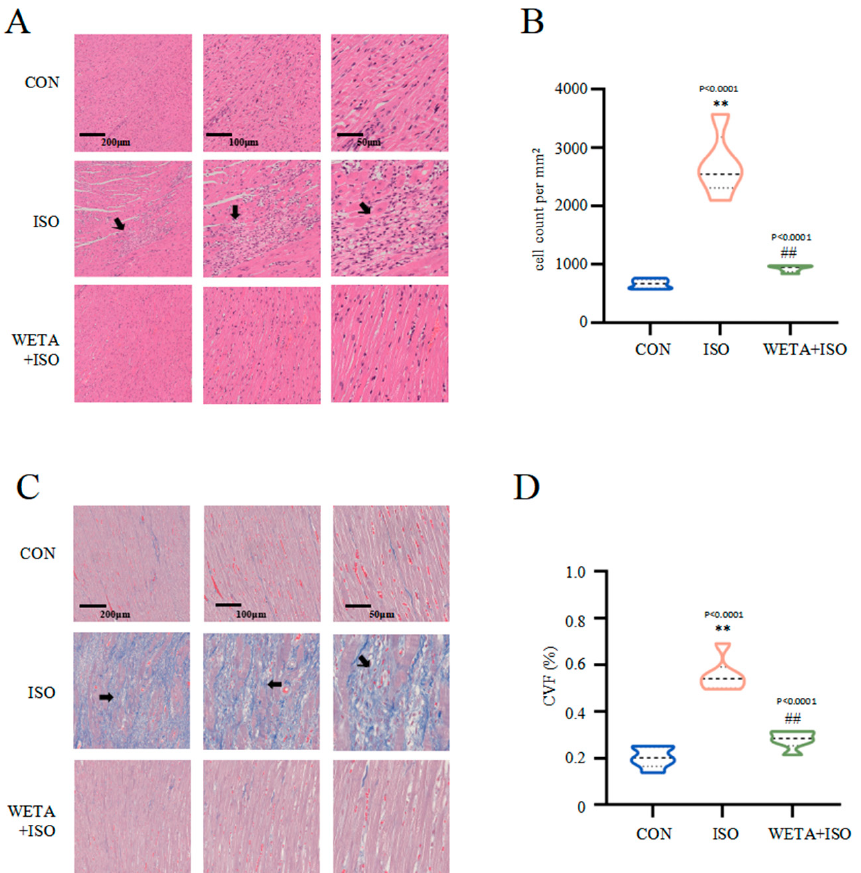
Figure 5. WETA attenuates histopathological changes. ( A ) H&E staining images of LV (From left to right, scale bar = 200 µ m, 100 µ m, 50 µ m), ( B ) Positive cells in the H&E stained slices were normalized and counted as cells/mm 2 , ( C ) Masson’s staining images of LV (From left to right, scale bar = 200 µ m, 100 µ m, 50 µ m), and ( D ) CVF of LV. Scale bar = 200 µ m, 200 µ m, 50 µ m. Black arrows: irregular cross striations of the myocardial tissue. Values are mean ± SD (n = 6), ** p < 0.01 vs. CON group; ## p < 0.01 vs. ISO group, from One-way ANOVA.